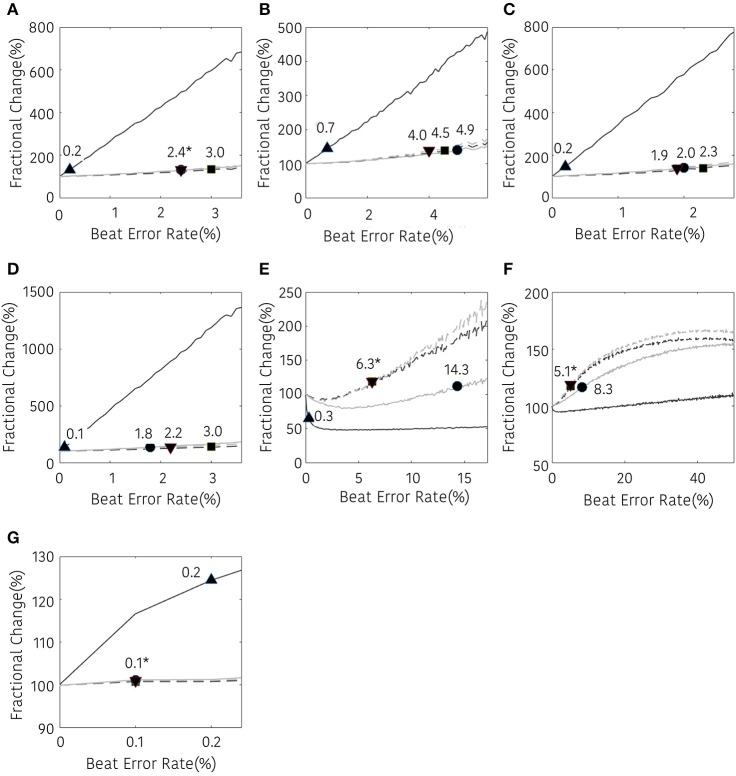
Result of frequency-domain HRV analysis according the beat error rate. The number in the figure represents the beat error rate that begins with a significant difference. The dark solid line, bright solid line, dark dashed line, bright dashed line indicate non-interpolated, NNI, LI, and CSI, respectively. (A) TP, (B) VLF, (C) LF, (D) HF, (E) LF/HF, (F) nLF, (G) nHF. Markers (▴, •, ■, ▾) represent the position of the error rates that start to have a statistically significant difference compared to the HRV variable derived with ectopic-free IBIs.